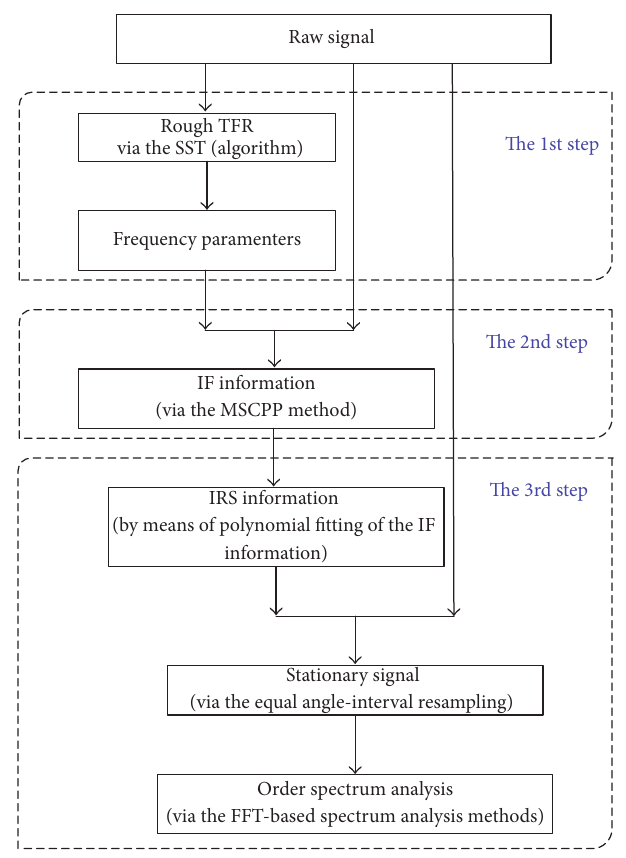
Figure 1: Overall structure of the proposed